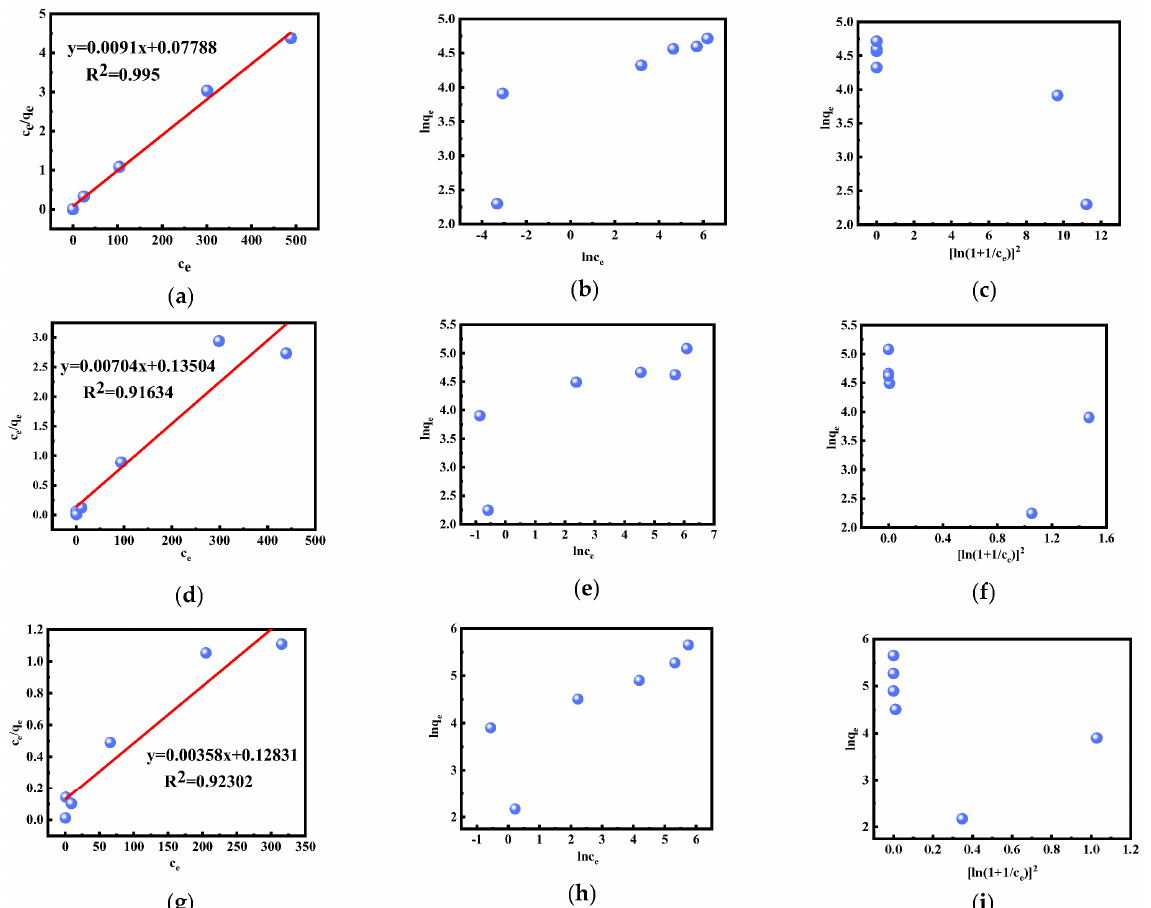
Figure 9. Isotherm fitting: ( a ) Langmuir model at 25 °C; ( b ) Freundlich model at 25 °C; ( c ) D–R model at 25 °C; ( d ) Langmuir model at 30 °C; ( e ) Freundlich model at 30 °C; ( f ) D–R model at 30 °C; ( g ) Langmuir model at 35 °C; ( h ) Freundlich model at 35 °C; and ( i ) D–R model at 35 °C.